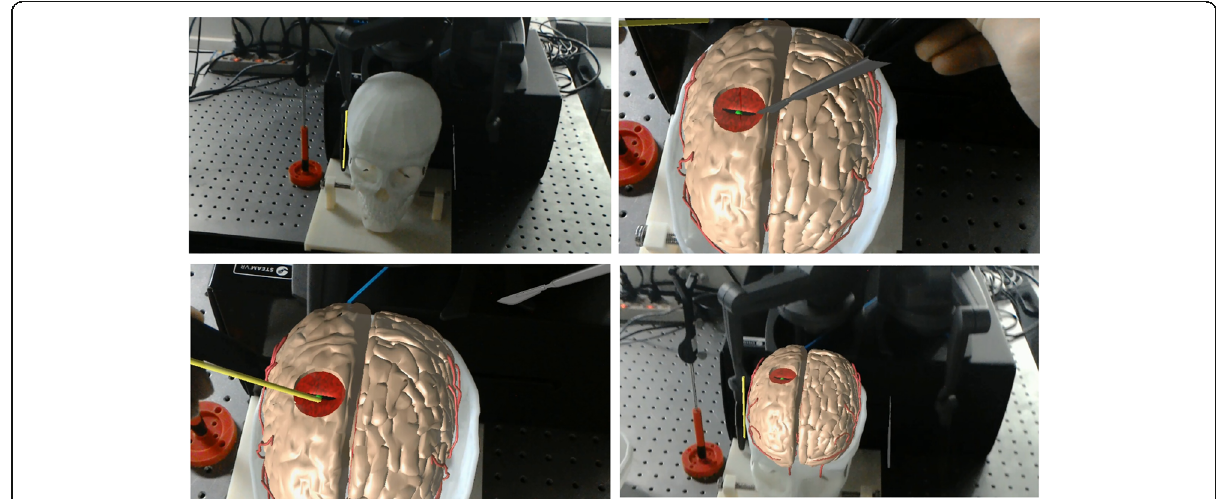
Fig. 5 Augmented reality guidance for